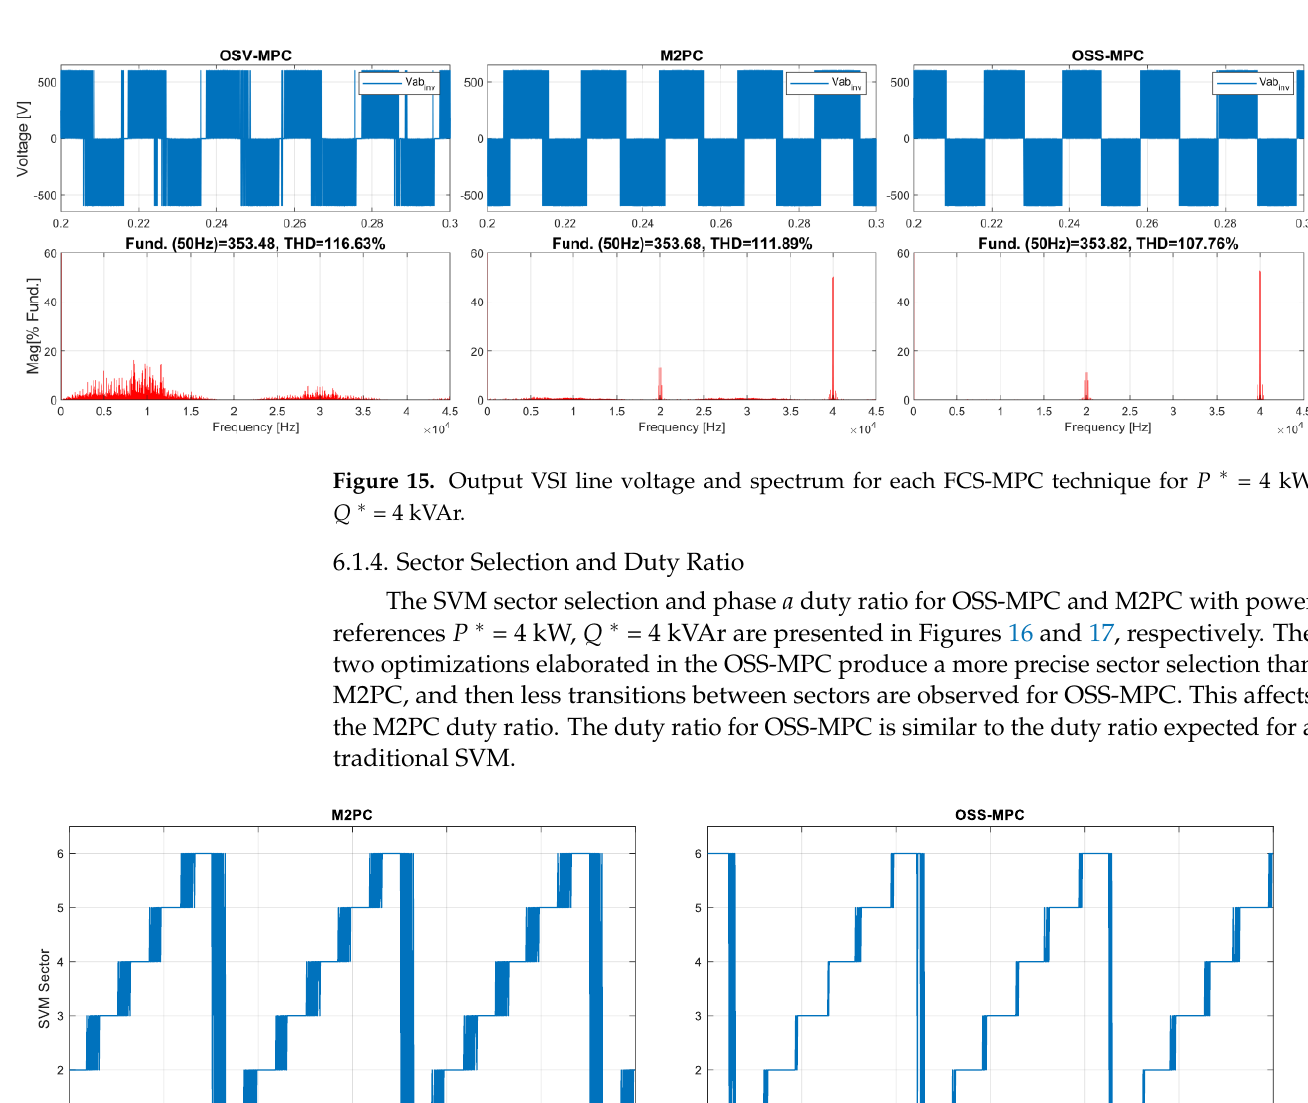
19 of 26 Figure 14. Output voltage, current, and current spectrum for each FCS-MPC technique for 𝑃 ∗ = 4 kW , 𝑄 ∗ = 4 kVAr. 6.1.3. VSI Line Voltage and Spectrum The VSI output line voltage and its harmonic spectrum are presented in Figure 15 for